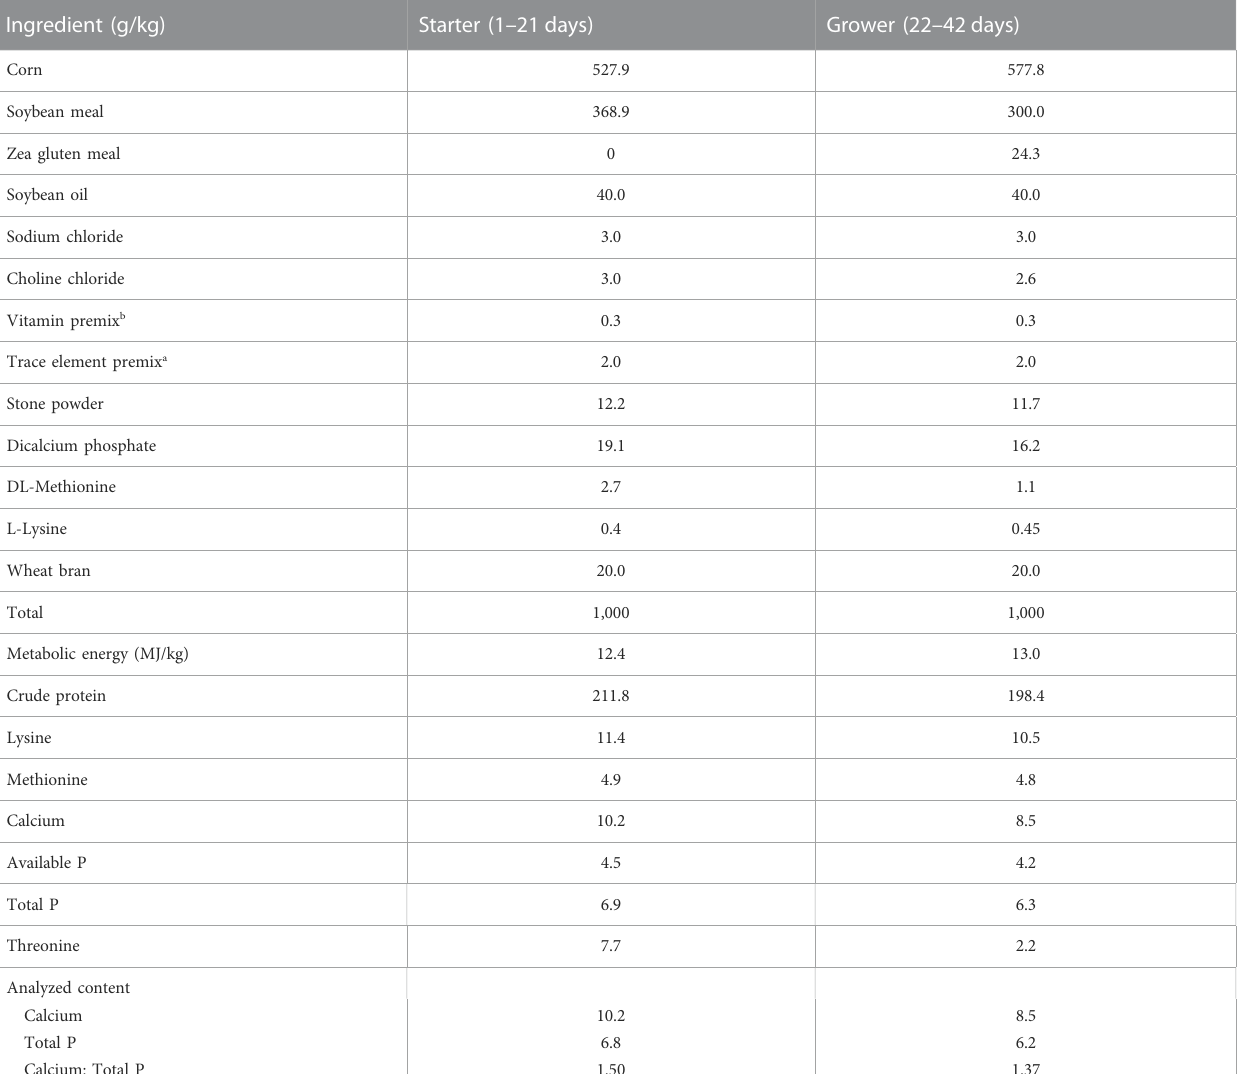
TABLE 1 Ingredients and nutrient levels in the basal diet. Ingredient